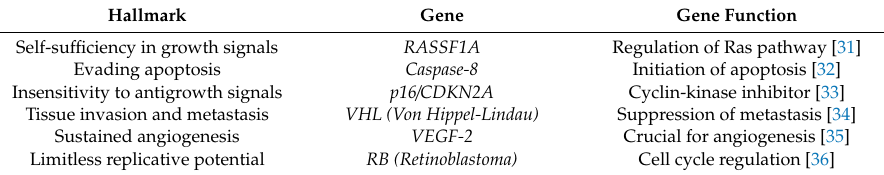
Table 1. Hallmarks of cancer and examples of genes silenced by aberrant